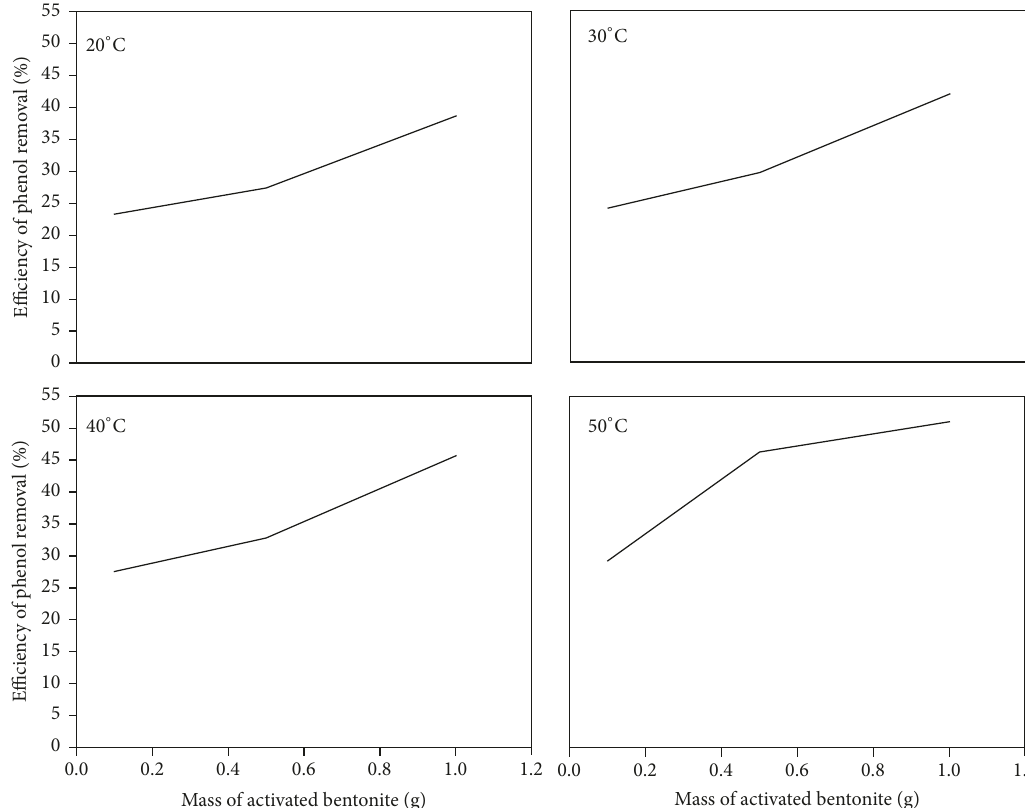
Figure 5: Effect of mass acid activated bentonite on percentage removal of total phenolic compounds.